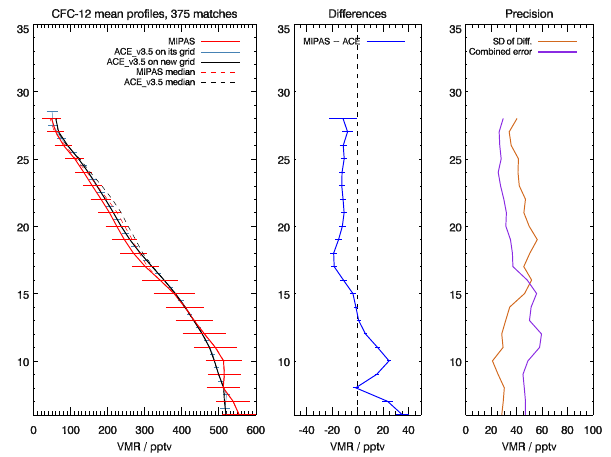
Figure 28. Comparison of mean profiles of MIPAS CFC-12 (left panel, continuous red line) and ACE-FTS (left panel: blue line denotes ACE-FTS on native grid; continuous black line denotes ACE-FTS interpolated onto the MIPAS grid) for February and March 2004, corresponding to the FR period and the MIPAS V5H_CFC-12_20 data set. The dashed lines show the median of each data set. The error bars include the total error for MIPAS and the random errors from the least-squares fitting process for ACE- FTS. The middle panel shows the mean difference (blue) of these profiles and the standard error of the mean. The right panel shows the combined error (purple) of the instruments and the standard de- viation of the differences (brown).